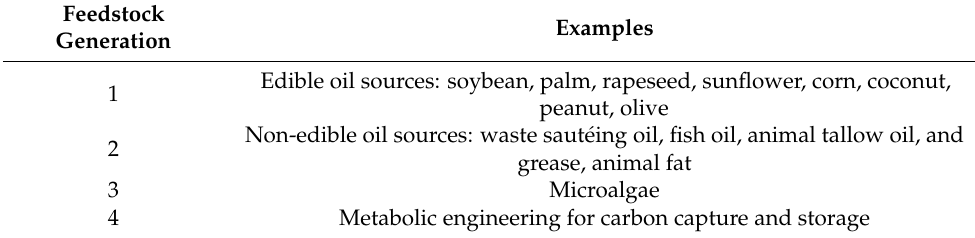
Table 2. Feedstock generation for biodiesel